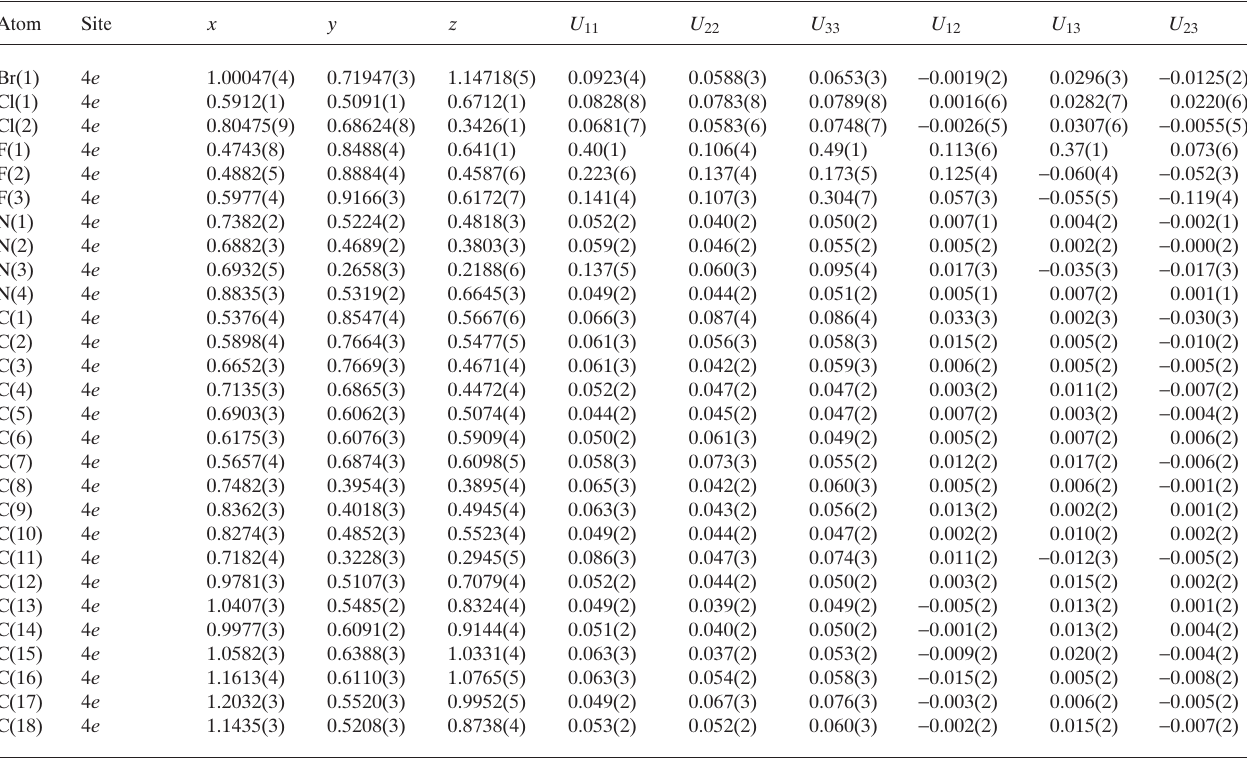
Table 3. Atomic coordinates and displacement parameters (in Å 2 )